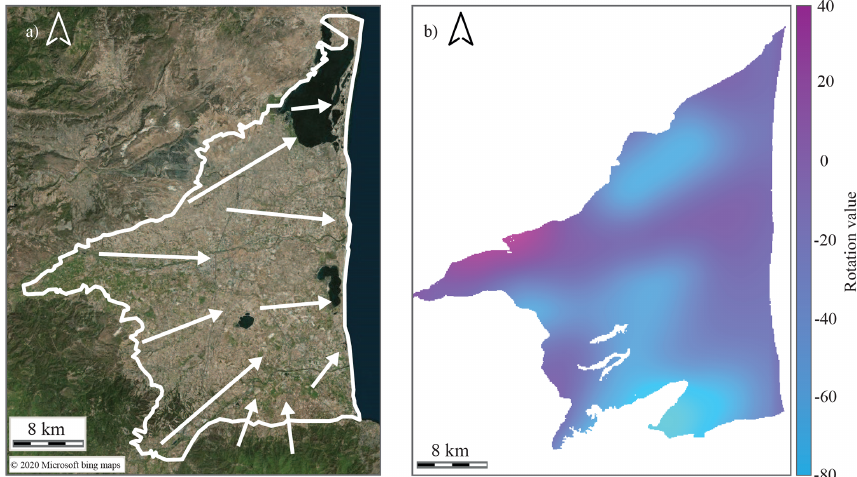
Figure 5. (a) Interpreted orientations of the paleo-rivers in the Roussillon plain. (b) Interpolated continuous kriged values, where a positive rotation value corresponds to a clockwise pattern rotation and a negative rotation value corresponds to a counterclockwise pattern rotation.